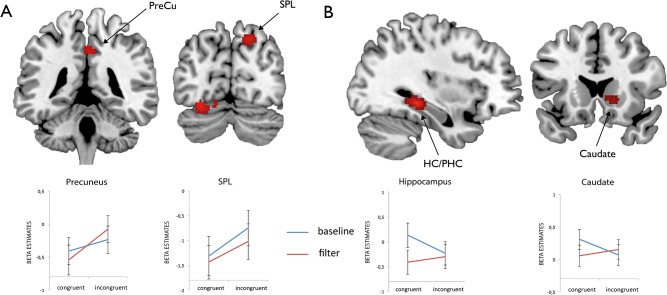
FMRI data for the second experimental run.Activations for the Flanker (A) and the interaction contrast (B) derived from the second experimental run as well as mean beta estimates extracted from a sphere with 4 mm radius around peak locations. Abbreviations: SPL superior parietal lobe, PreCu precuneus, HC hippocampus, PHC parahippocampal cortex.